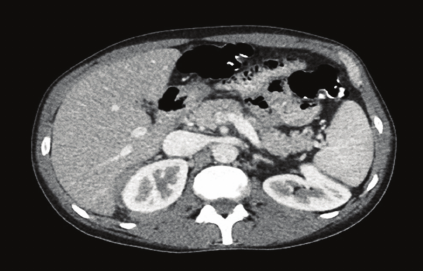
Figure 3: Contrast-enhanced computed tomography at the level of pancreas after 3 months of cyclophosphamide, doxorubicin, vincristine, and prednisone (CHOP) treatment demonstrating near complete resolution of previously seen soft tissue